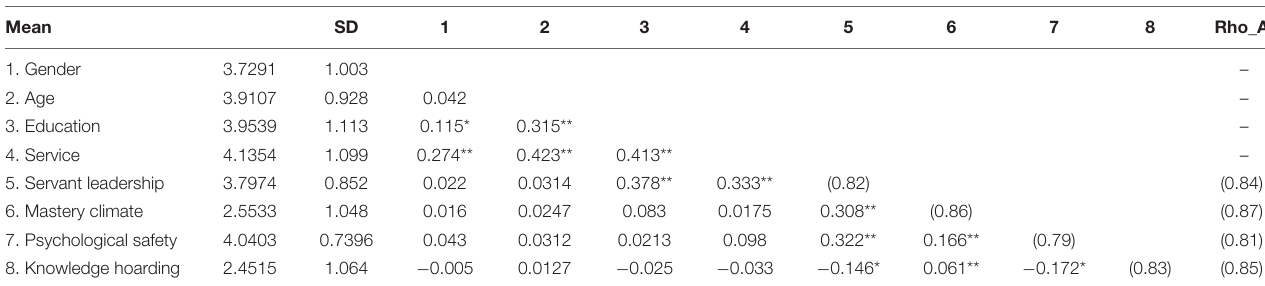
TABLE 1 | Mean, standard deviation, correlations, reliability, and rho_A. Mean